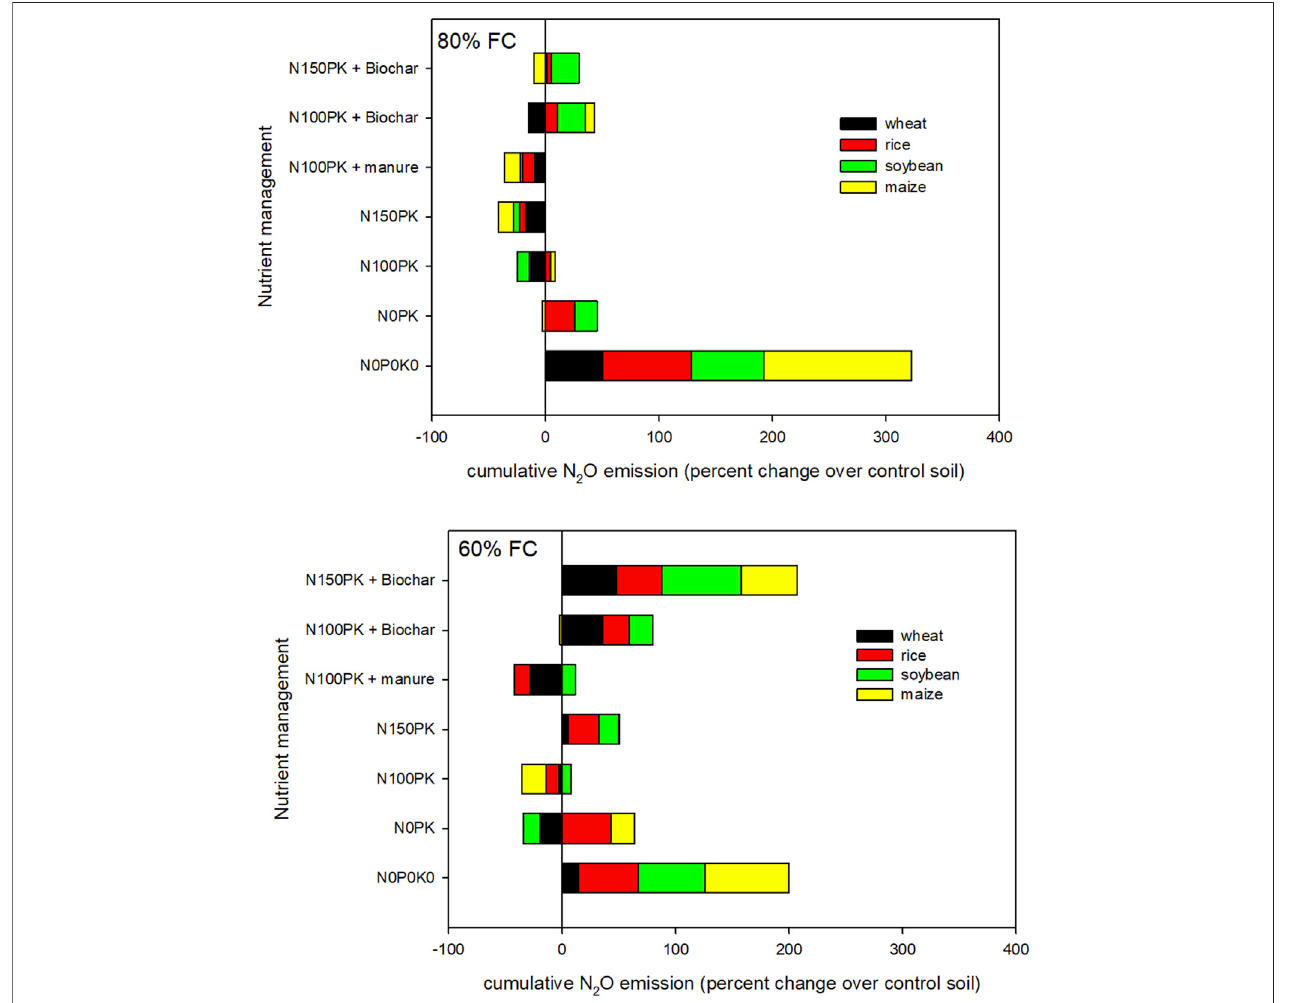
FIGURE3| Comparative changein cumulative soil nitrous oxide fl ux (µg-N kg − 1 soil)in residue-returned soil over residue-control soil underdifferentresidue types, nutrients, and soil moisture levels after 87 days of incubation.